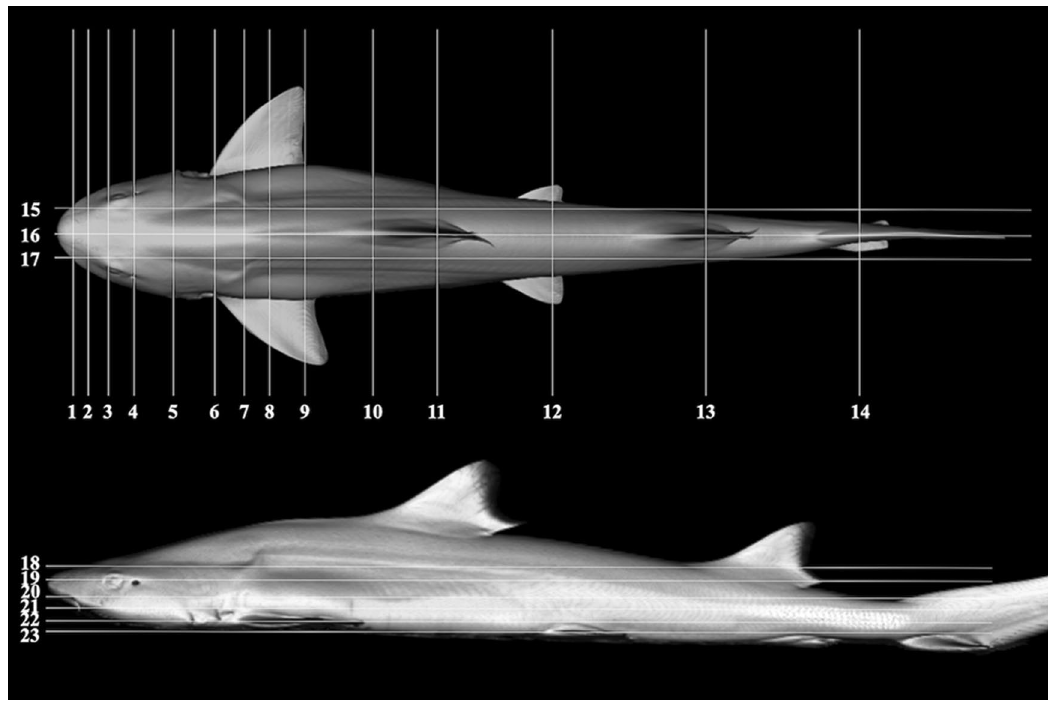
Figure 25. Three-dimensional surface reconstructions of a banded houndshark ( Triakis scyllium ) from computed tomography (CT) scans, indicating approximate levels of transverse, sagittal, and dorsal sections corresponding to Figs. 1, 2, 3, 4, 5, 6, 7, 8, 9, 10, 11, 12, 13, 14, Figs. 15, 16, 17, and Figs. 18, 19, 20, 21, 22, 23, respectively. Slices 1–4 are approximately 2 cm intervals, slices 4–9 are approximately 5 cm intervals, slices 9–11 are approximately 6 cm intervals, slices 11–14 are approximately 12 cm intervals, slices 15–17 are approximately 3 cm intervals, and slices 18–23 are approximately 1 cm